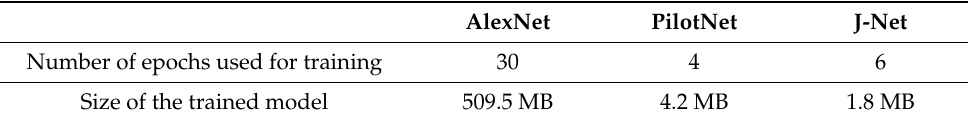
Table 3. Size of the trained models: J-Net, PilotNet, and AlexNet.